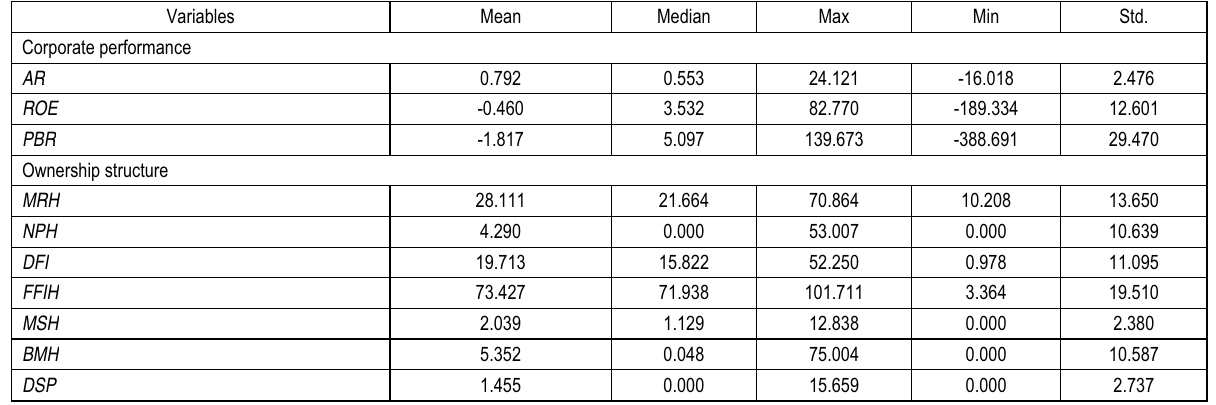
Table 2. Descriptive statistics of